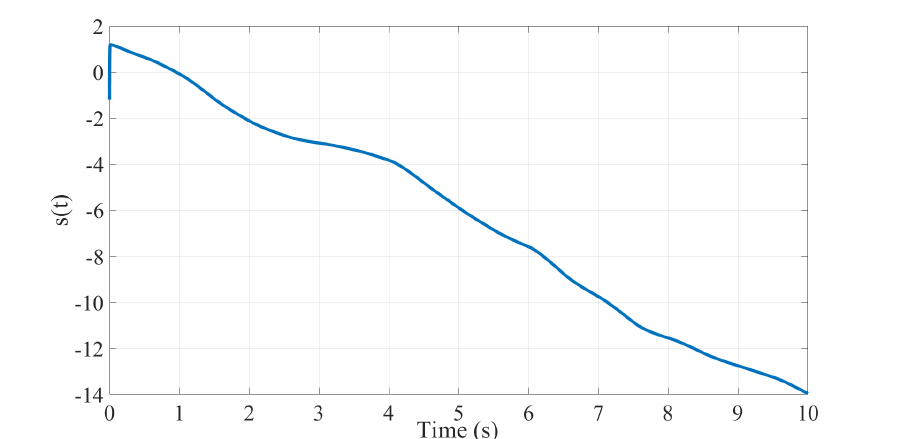
Figure 16. Sliding surface SMC and constant input.